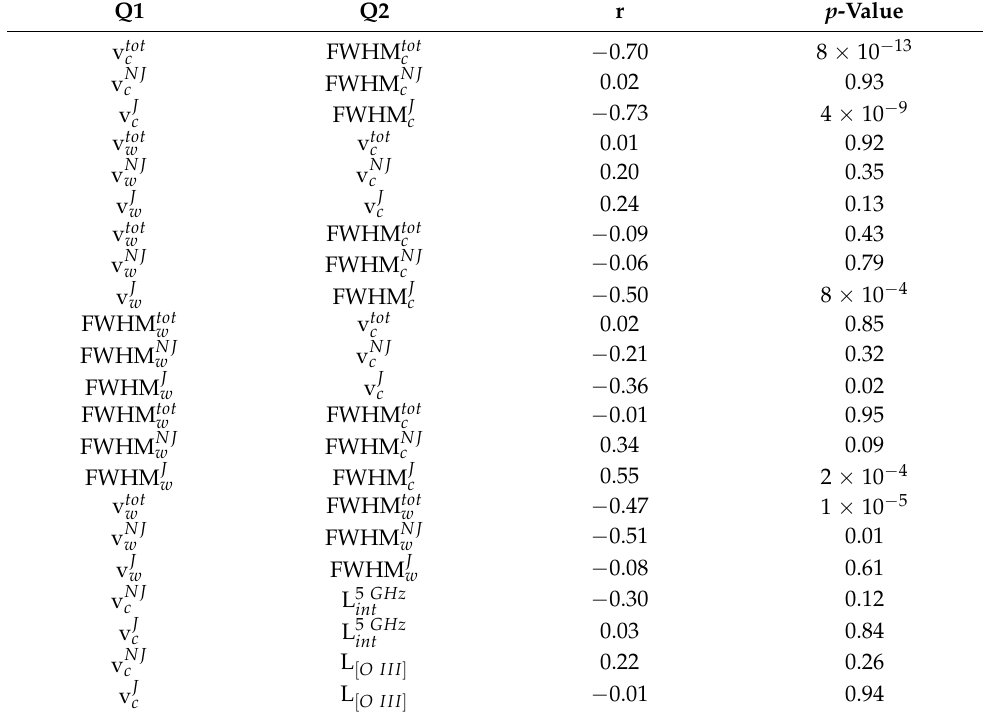
Table 6. Results of the correlations tested throughout this work. Columns: (1) First tested sample; (2) second tested sample; (3) Pearson correlation coefficient; (4) p